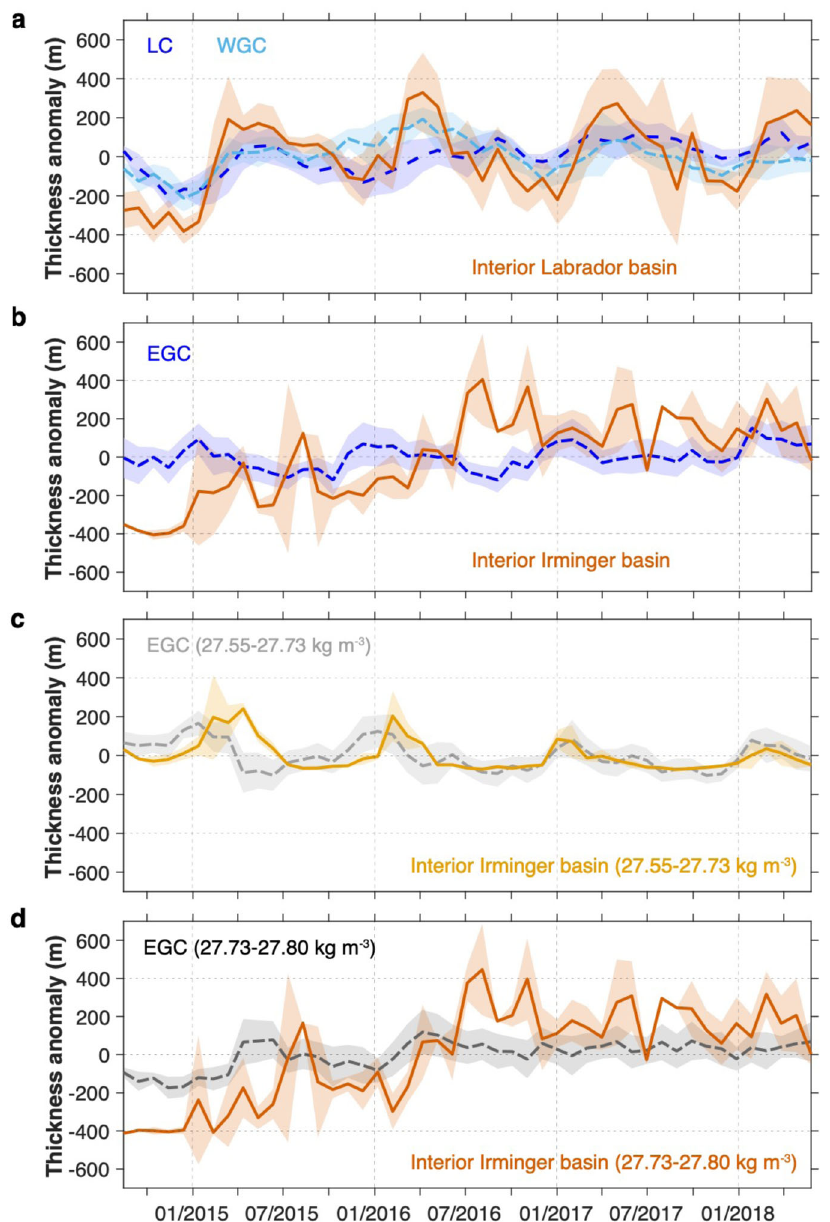
Fig. 3 Upper North Atlantic Deep Water (UNADW) layer thickness anomalies. a Labrador Sea: UNADW layer ( σ θ = 27.70 – 27.80 kg m − 3 ) thickness anomalies across the full Labrador Current (LC; dark blue) and West Greenland Current (WGC; light blue) arrays (see Fig. 1b for location), respectively, with shading represents uncertainty; layer thickness anomalies in the Labrador Sea interior (red, shading represents ±1 standard deviation) computed from Argo data north of the OSNAP line where sea fl oor >3000 m deep (Methods). b Irminger Sea: UNADW ( σ θ = 27.55 – 27.80 kg m − 3 ) layer thickness anomalies across the East Greenland Current (EGC) array of tall moorings within the boundary current (blue; see Fig. 1b for location), with shading represents uncertainty; layer thickness anomalies in the Irminger Sea interior (red, shading represents ±1 standard deviation) computed from Argo data north of the OSNAP line where sea fl oor >2000m deep (Methods). c , d Irminger Sea: similar as in ( b ), but for the lightest ( σ θ = 27.55 – 27.73 kg m − 3 )